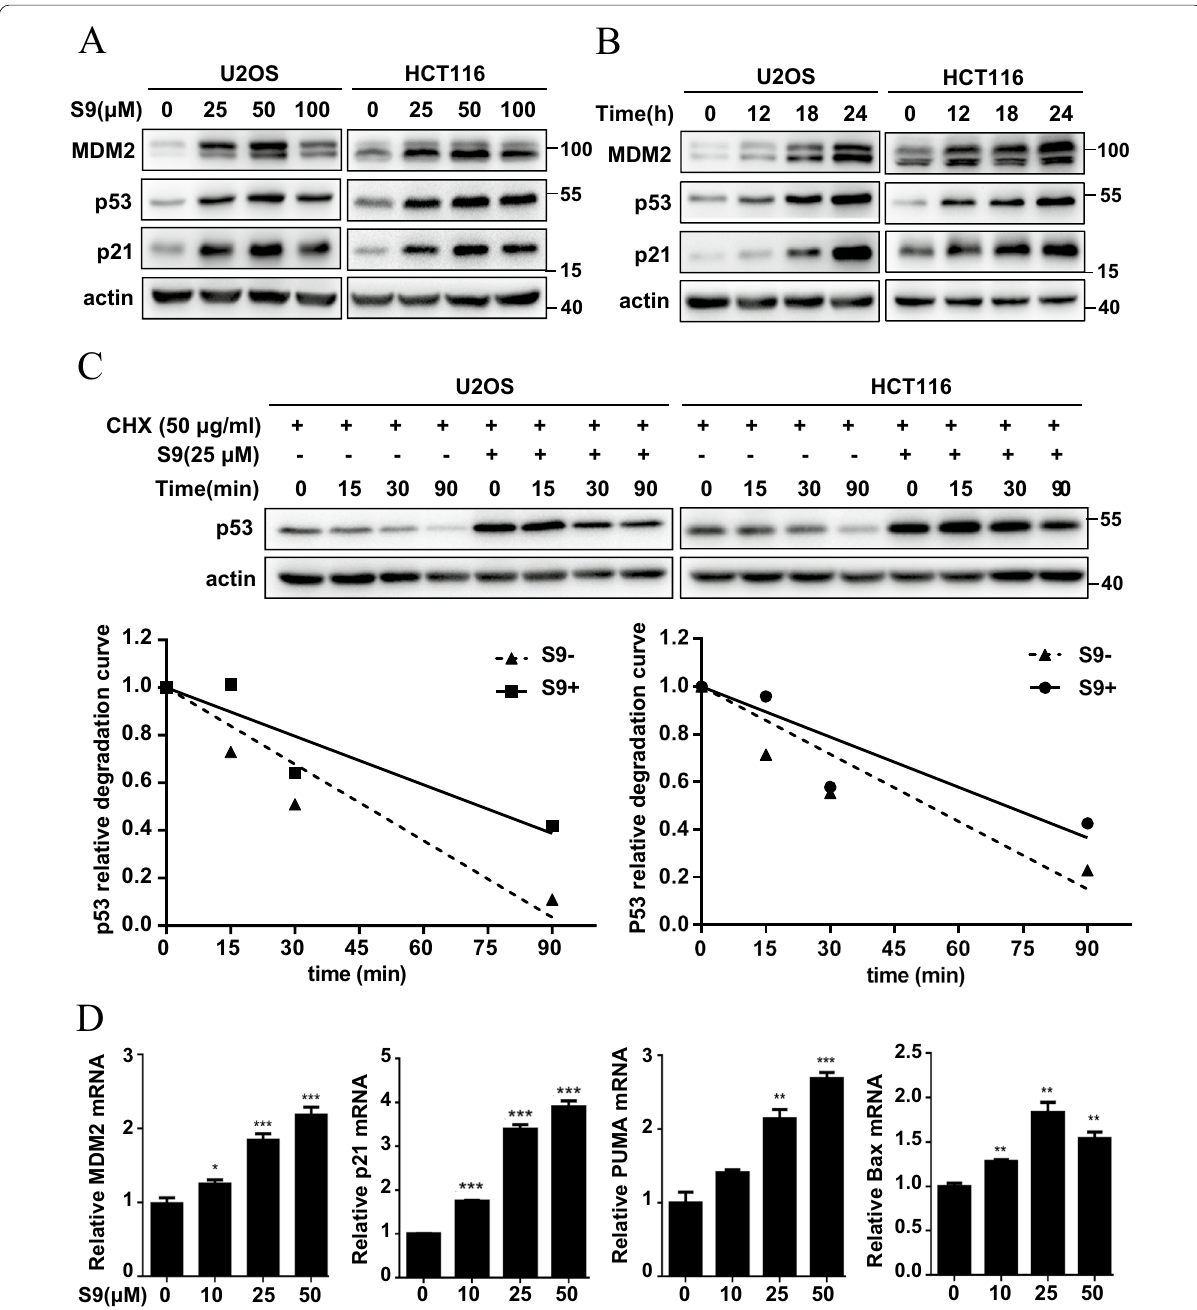
Fig. 4 S9 stabilizes p53 and increases p53 transcriptional activity. A U2OS and HCT116 cells were treated with described concentration of S9 for 24 h. MDM2, p53 and p21 protein levels were detected by western blot analysis. B U2OS and HCT116 cells were treated with 50 μM of S9 for different time course. MDM2, p53 and p21 protein levels were detected by western blot analysis. C U2OS and HCT116 cells were treated with or without 25 μM of S9 for 24 h followed with cycloheximide (CHX, 50 μg/ml), and harvested at the indicated time points. p53 and actin levels were detected by western blot analysis. p53 expression normalized with actin was quantified using Image J software. D U2OS cells were treated with described concentration of S9 for 24 h. mRNA levels of MDM2, p21, Puma and Bax were analyzed by RT-PCR. Fold expression changes are relative to the control and correspond to mean SD of three independent ±